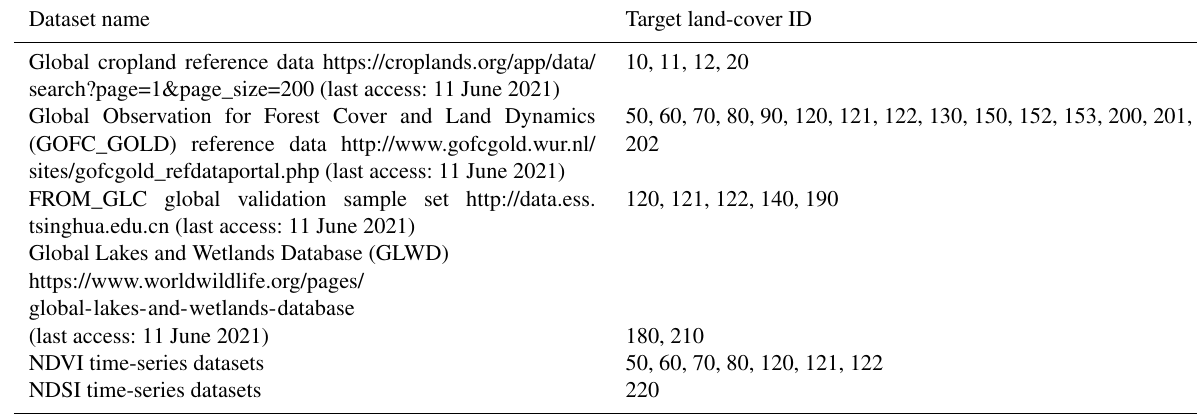
Table 1. Multi-source auxiliary datasets used for collecting the global validation samples. Dataset name